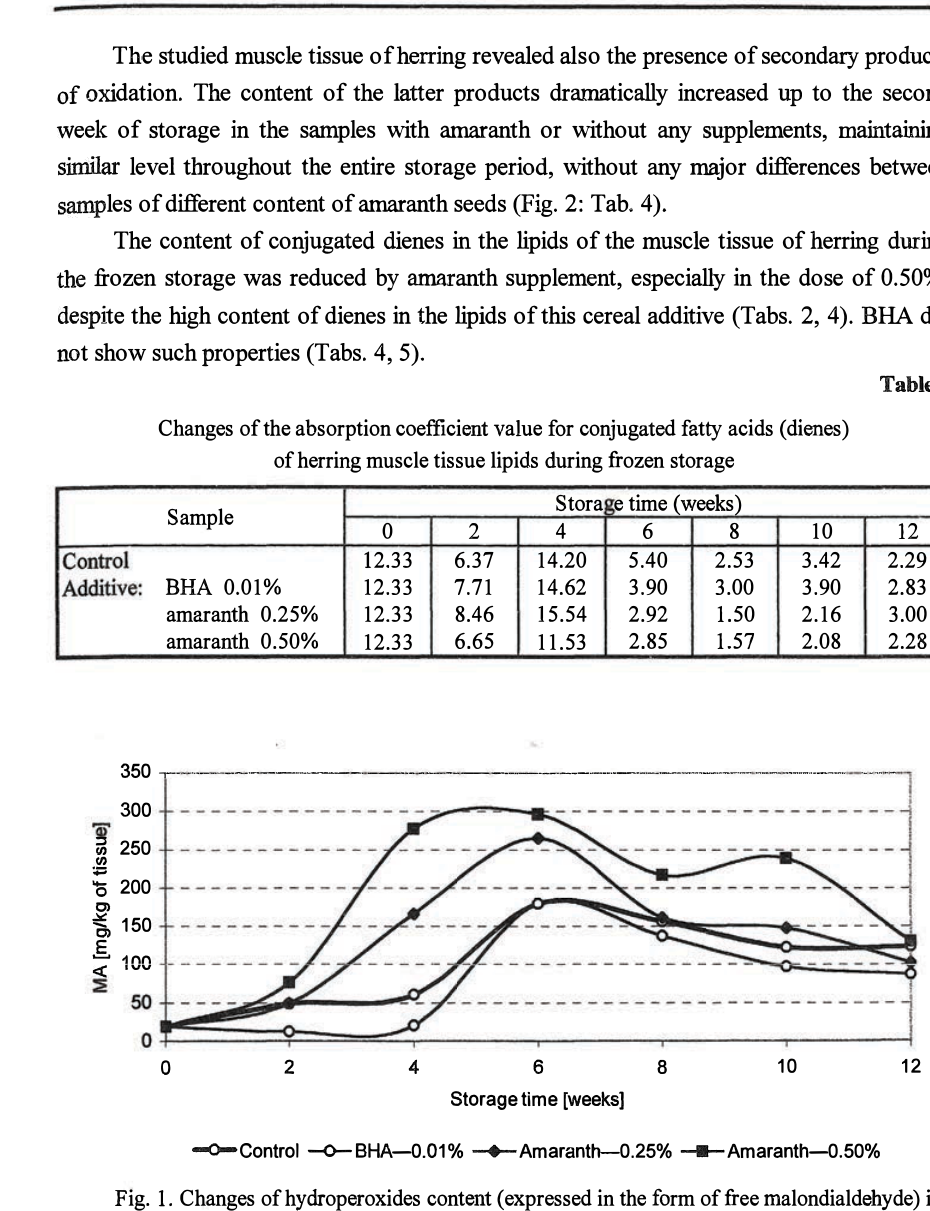
-o,,..control -O-BHA-0.01% -+-Amaranth-0.25% --111-Amaranth-0.50% Fig. I. Changes ofhydroperoxides content (expressed in the form of free malondialdehyde) in the muscle tissue of herring during frozen storage ( chloroform layer of the extracts) Supplement of 0.50% of amaranth seeds to the muscle tissue of herring in a similar way inhibited formation of both dienes and trienes, while in the dose of 0.25% this additive uuu..,.....,.1 as BHA catalysed build-up oftrienes during the frozen storage (Tabs. 4,